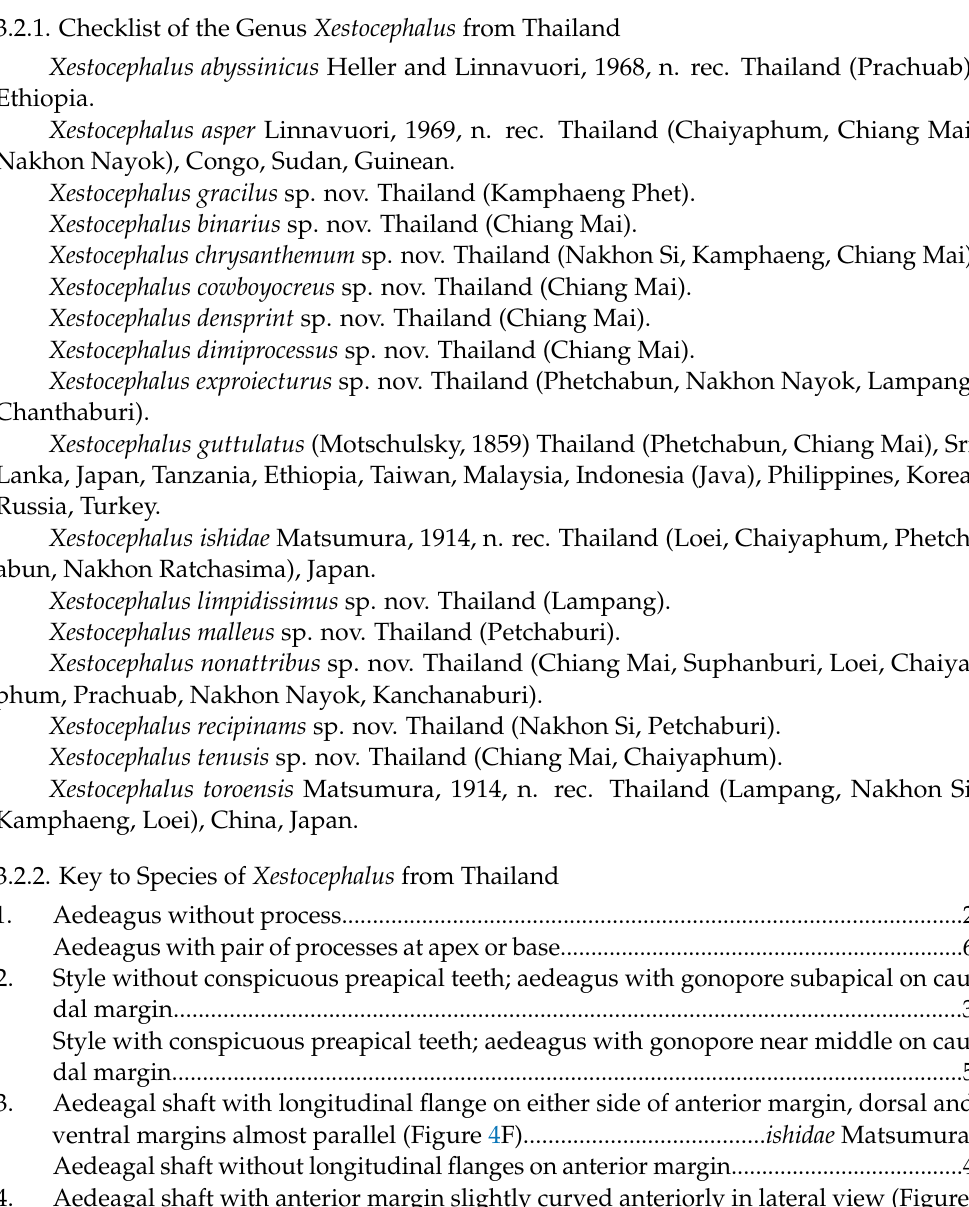
4. Aedeagal shaft with anterior margin slightly curved anteriorly in lateral view (Figure 2F,H), tapering to apex in ventral view (Figure 2E,G) ........................... asper Linnavuori - Aedeagal shaft with anterior margin straight in lateral view (Figure 3F), broadened apically in ventral view (Figure 3E). ........................................... guttulatus (Motschulsky) 5. Pygofer without internal process (Figure 7B); aedeagal shaft compressed (Figure 7E–G) in posterior view, robust in lateral view (Figure 7H–J) ........ nonattribus sp. nov. - Pygofer with internal processes present (Figure 6B); aedeagal shaft columnar, slender in lateral view (Figure 6F)............................................................................ gracilus sp.